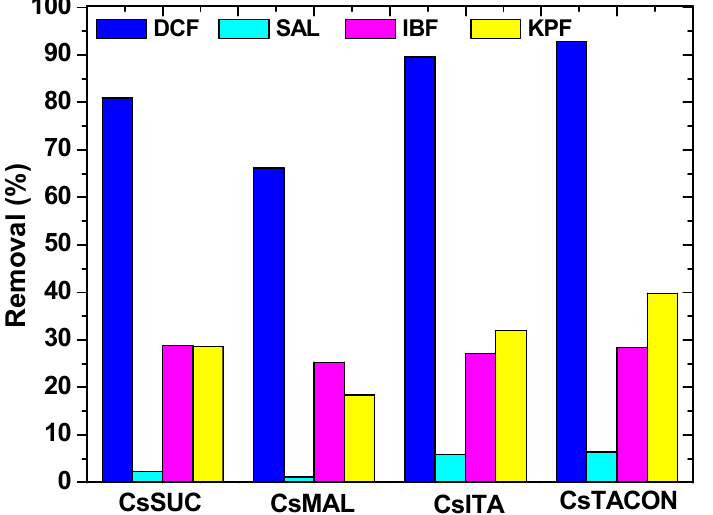
Figure 11. Adsorption of various drug compounds by chitosan adsorbents.